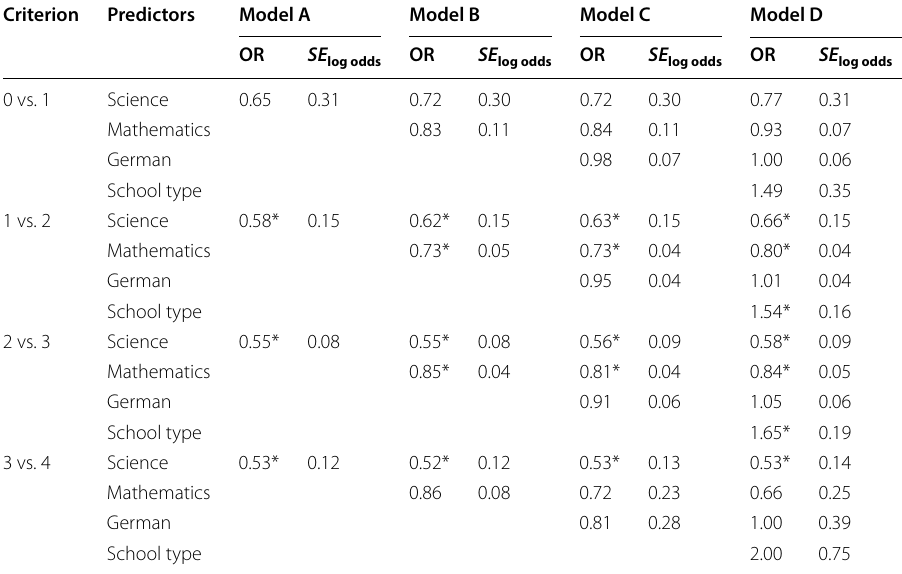
Table 5 Multinomial regression of number of lessons per week on